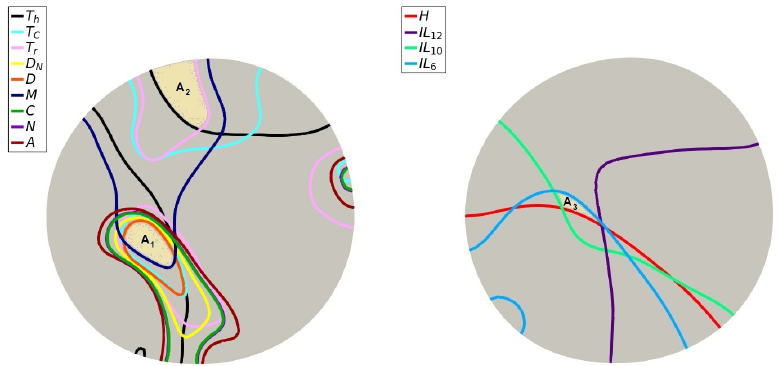
Figure 6. ( Left ): Level-curves indicating the mean value of each cell type at t = 600. ( Right ): Level- curves indicating the mean value of each molecule at t = 600. Areas A 1 and A 2 correspond to the regions with the most and second-most immune cell intersections, respectively. Area A 3 corresponds to the region with the highest cytokine